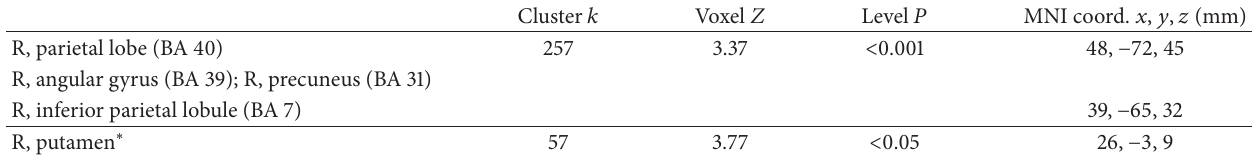
Table 2: Grey matter reduction in PD patients with respect to controls at baseline (test).